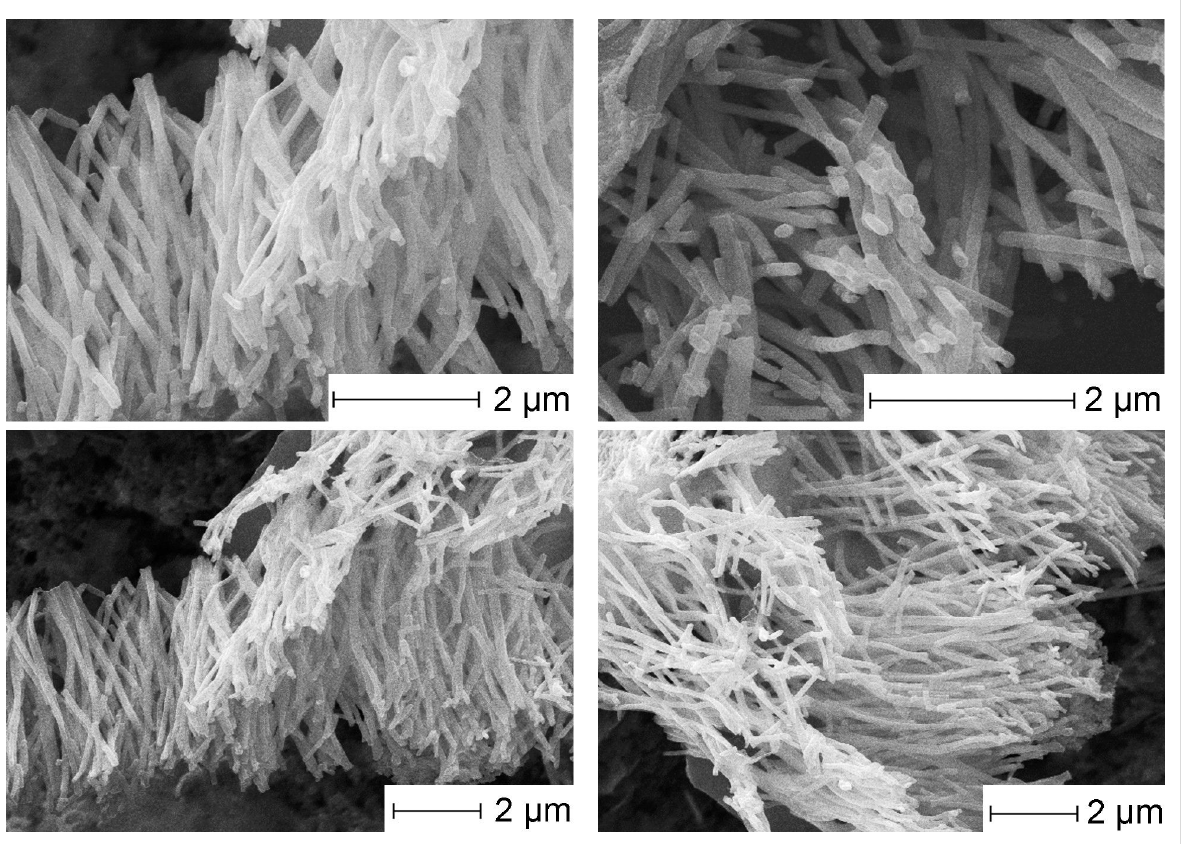
Figure 1: SEM micrographs of CuInSe 2 nanorod arrays after the final conversion step at 450 °C.